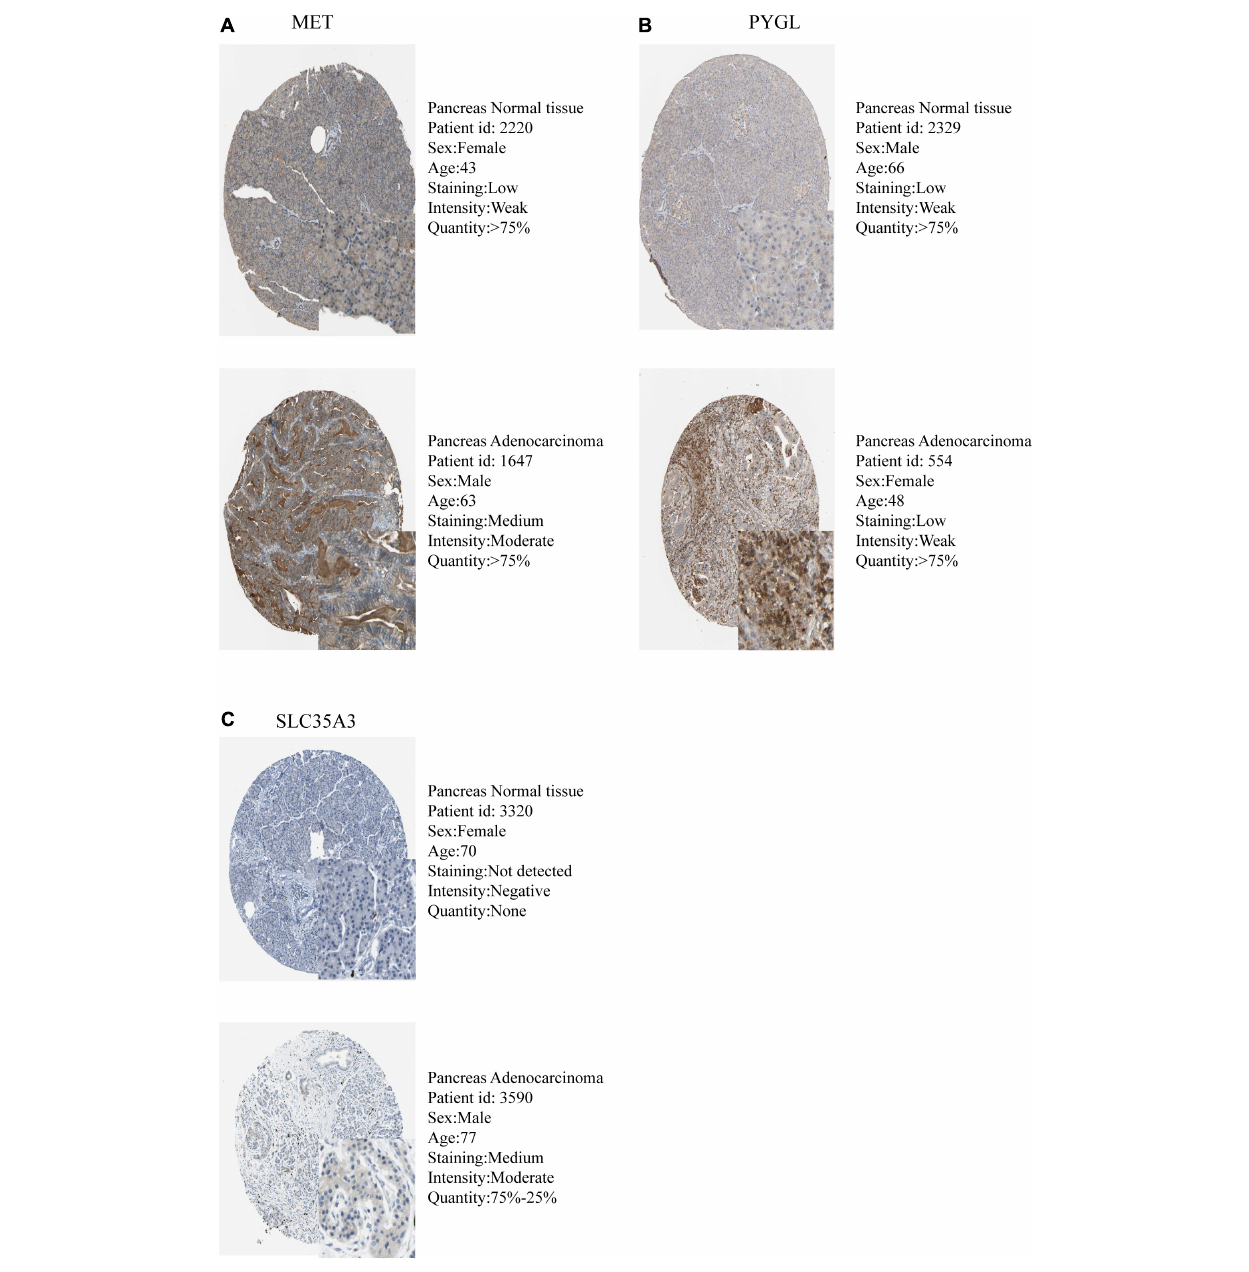
FIGURE 7 | Validation of model GRGs IHC images obtained from the Human Protein Atlas database (A–C)